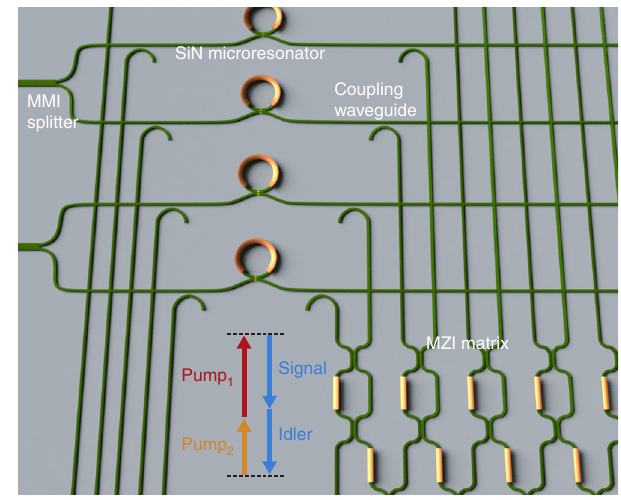
Fig. 1 Conceptual schematic of a network of coupled degenerate optical parametric oscillators. Two-frequency nondegenerate pumps are injected into the network of coupled degenerate optical parametric oscillators (DOPOs) based on silicon nitride (SiN) microresonators. The pumps are split on-chip using multimode interference (MMI) splitters. The DOPO signal is phase matched and generated via four-wave mixing parametric oscillation. Phase-matching conditions result in a bi-phase state for the generated signal. Coupling between DOPOs can be performed using a matrix of recon fi gurable Mach – Zehnder interferometers